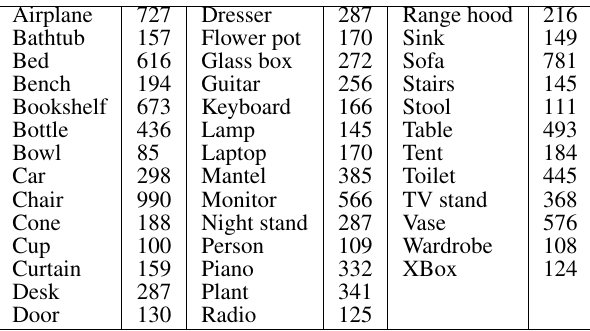
Table 1. ModelNet object